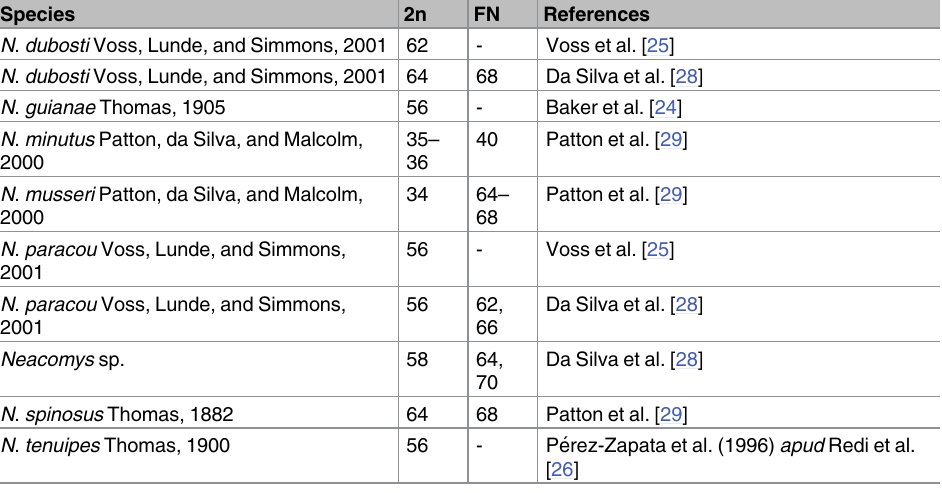
Table 1. Cytogenetic data available for Neacomys genus, with diploid number (2n) and autosomal fundamental number (FN). Species 2n